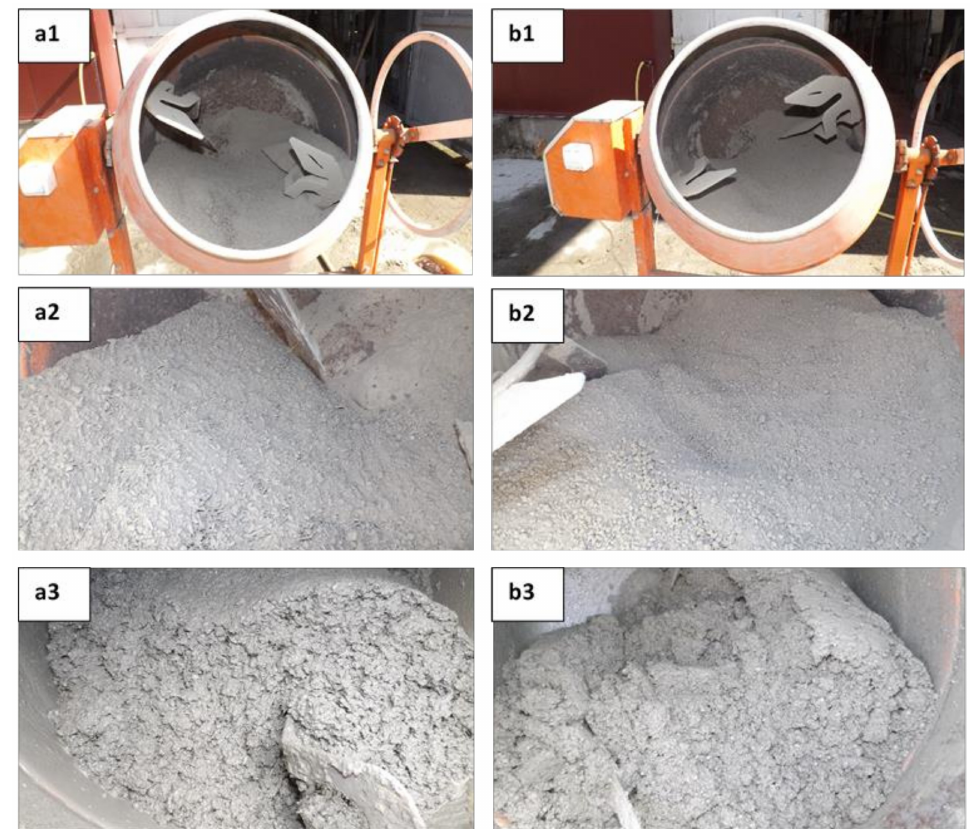
Figure 2. Composition preparation: ( a1 ) dry components of sunflower stalks composites, mixed within portable electric concrete mixer; ( a2 ) dry components of sunflower stalks composites, close up view; ( a3 ) sunflower stalks composite in fresh state; ( b1 ) dry components of corn cobs composites, mixed within portable electric concrete mixer; ( b2 ) dry components of corn cobs composites, close up view; ( b3 ) corn cobs composite in fresh state.